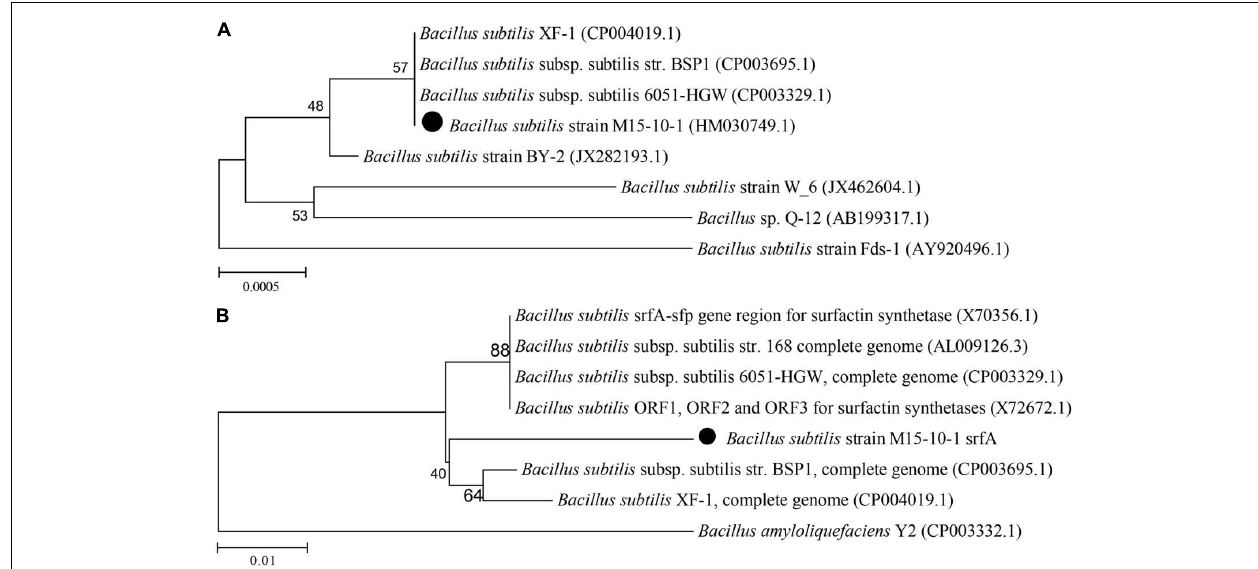
FIGURE 2 | Phylogenetic relationship based on (A) the 16S rDNA gene and (B) srfA gene sequences between the Bacillus subtilis M15-10-1 strain and related species.